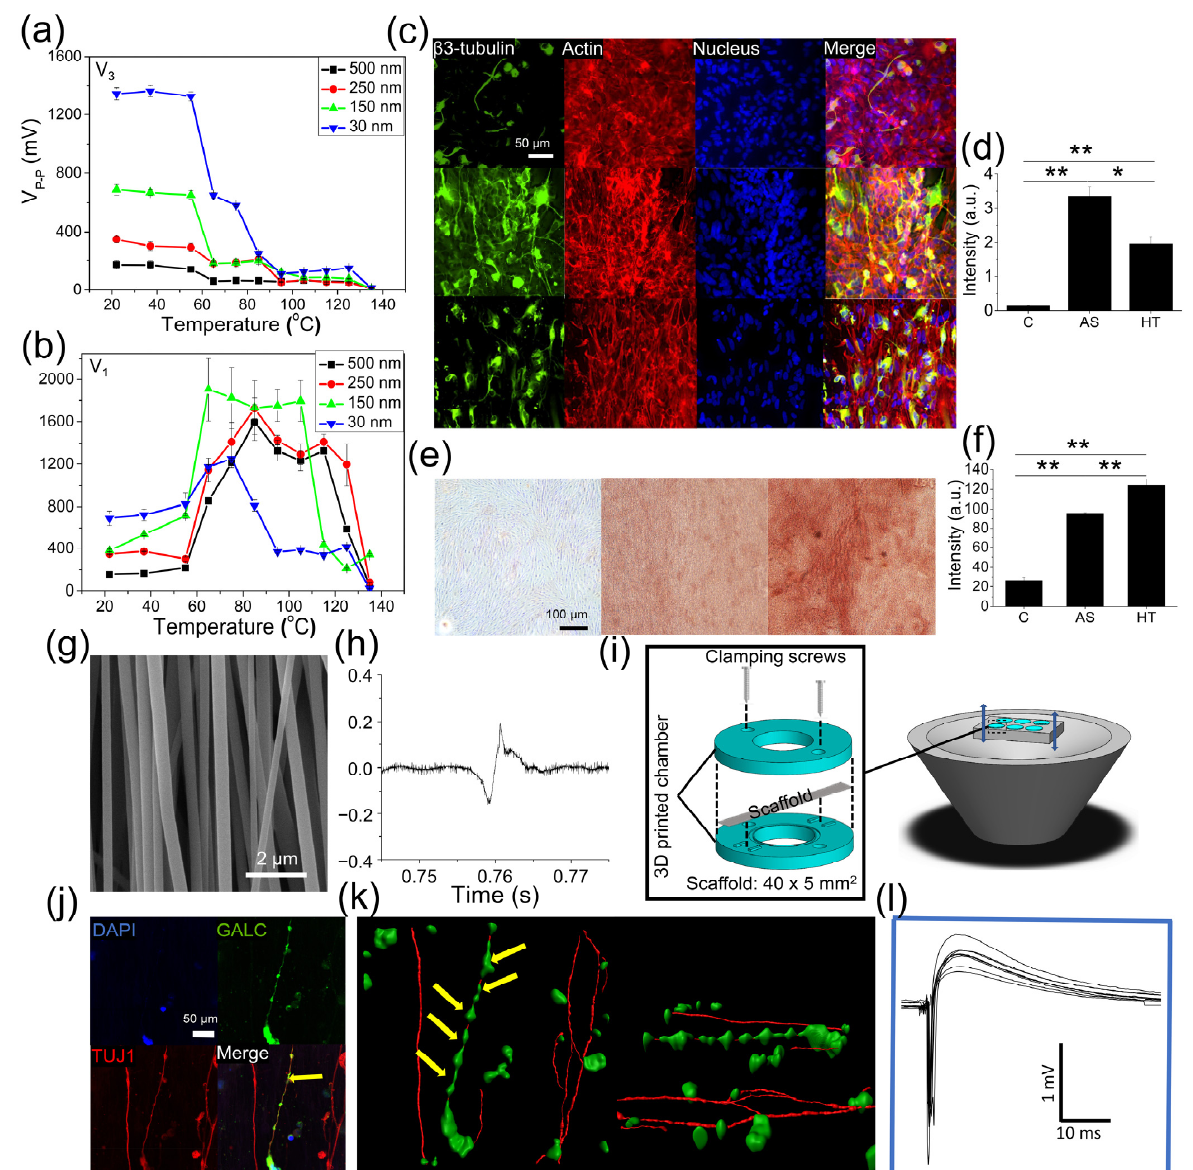
Figure 4. Utilization of piezoelectric polymeric scaffolds for guided stem cell differentiation. ( a , b ) Electric outputs of electrospun PLLA nanofibers with various fiber diameters and heat treatment regimens in the ( a ) transverse direction or ( b ) longitudinal direction. ( c , d ) Immunofluorescence images of human NSCs cultured on (( c ), top) tissue culture plate, (( c ), middle) as-spun, or (( c ), bottom) 65 °C heat-treated PLLA nanofibers for 1 week showing different degrees of neuronal differentiation, quantified by the intensity of neuronal β 3-tubulin expression. ( e , f ) Histological images of human MSCs cultured on (( e ), left) tissue culture plate, ( e , middle) as-spun, or ( e , right) 65 °C heat-treated PLLA nanofibers for 2 weeks showing different degrees of osteogenic differentiation, quantified by the intensity of osteogenic calcium deposition via Alizarin red staining [155]. (* and ** denote statistical significance of p < 0.05 and p < 0.01, respectively.) ( g ) an SEM image of electrospun-aligned P(VDF-TrFE) nanofibrous scaffold and ( h ) its voltage output under 0.03% of strain. ( i ) A schematic showing a cell culture system for the acoustic activation of the piezoelectric P(VDF-TrFE) scaffolds. ( j ) Representative fluorescent images and ( k ) their Imaris 3D reconstruction showing neuron-oligodendrocytic interaction. ( l ) A representative graph showing action potentials generated from neurons derived from NSCs by mechano-electrical stimulation [153]. This study demonstrates that the activation of piezoelectric scaffolds by exogeneous mechanical stimulation leads to more significant prolonged effects on tissues and cells as compared to static piezoelectric cell culture platforms. The development of highly